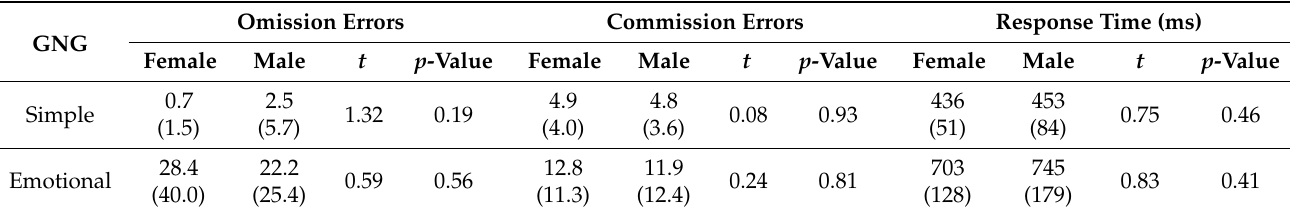
Table 1. Subject’s performance: mean and standard deviation of omission errors, commission errors, and response time during the simple and emotional GNG task by